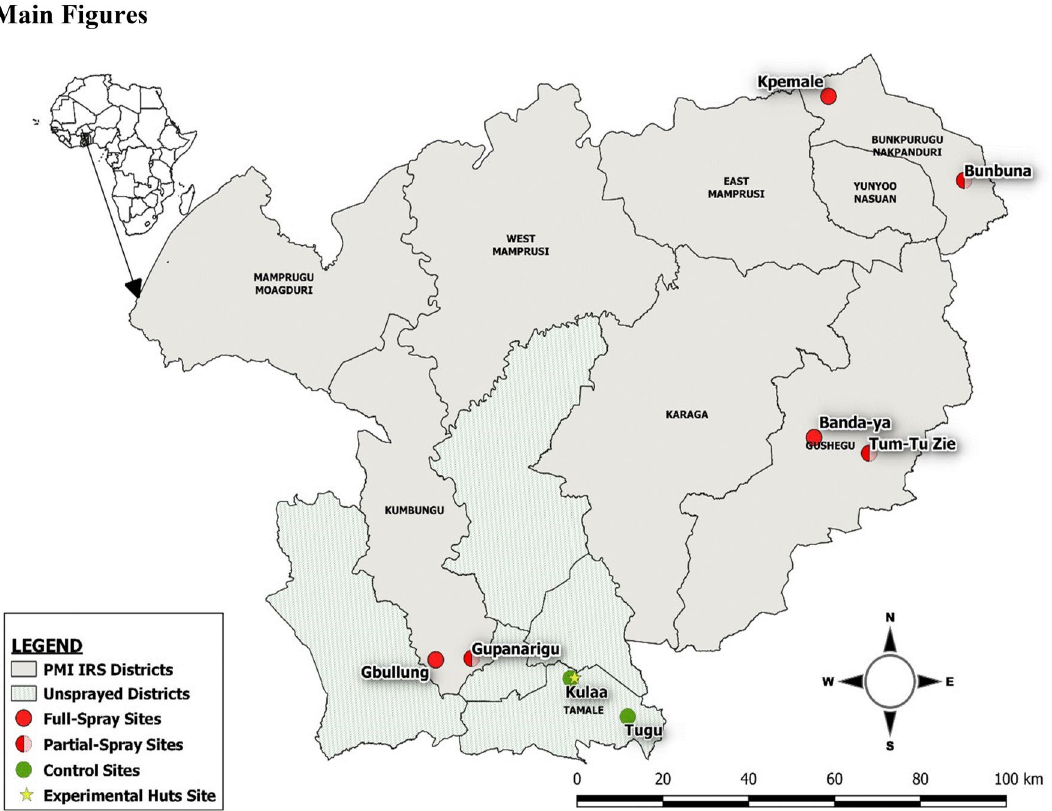
Figure 1. Partial IRS Study Sites in northern Ghana. Partial IRS was evaluated in an experimental hut study at one site (yellow star) in Tamale Metropolitan District and subsequently in a village-scale trial conducted in four districts in northern Ghana. In Kumbungu, Bunkpurugu Nakpanduri, and Gushegu districts one community was partially sprayed (red/pink semi-circles) and one was fully sprayed (red circles). The trial also included two unsprayed communities (green circles) in Tamale Metropolitan